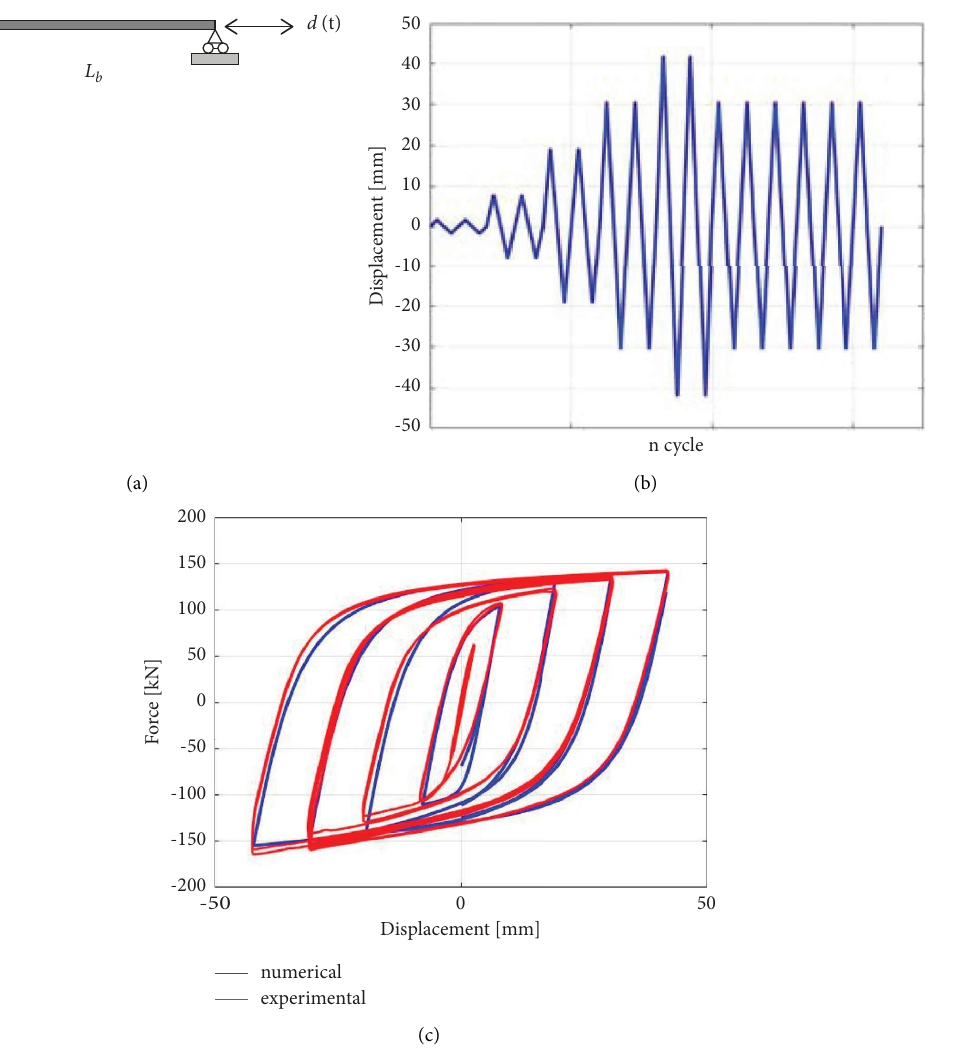
Figure 4: AISC test: numerical model (a), applied displacement load (b), and experimental and numerical load-deformation hysteretic curves